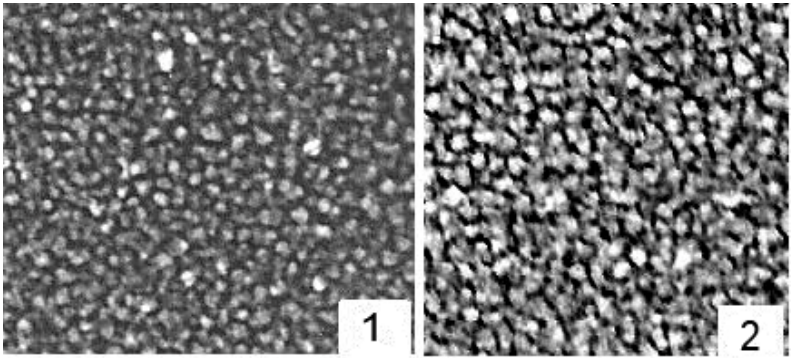
Figure 2. Transmission electron microscope (TEM) images of the Au-filled PTFE